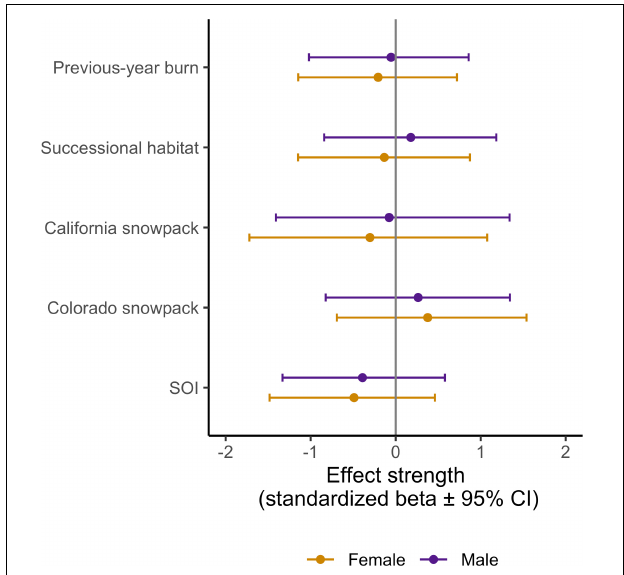
FIGURE 6 | Effect strength (standardized beta values ± 95% CI) for each of the migratory variables we considered as a potential driver of adult apparent annual survival (see Table 1 and Figure 3 ). Vertical gray line (beta = 0) implies no